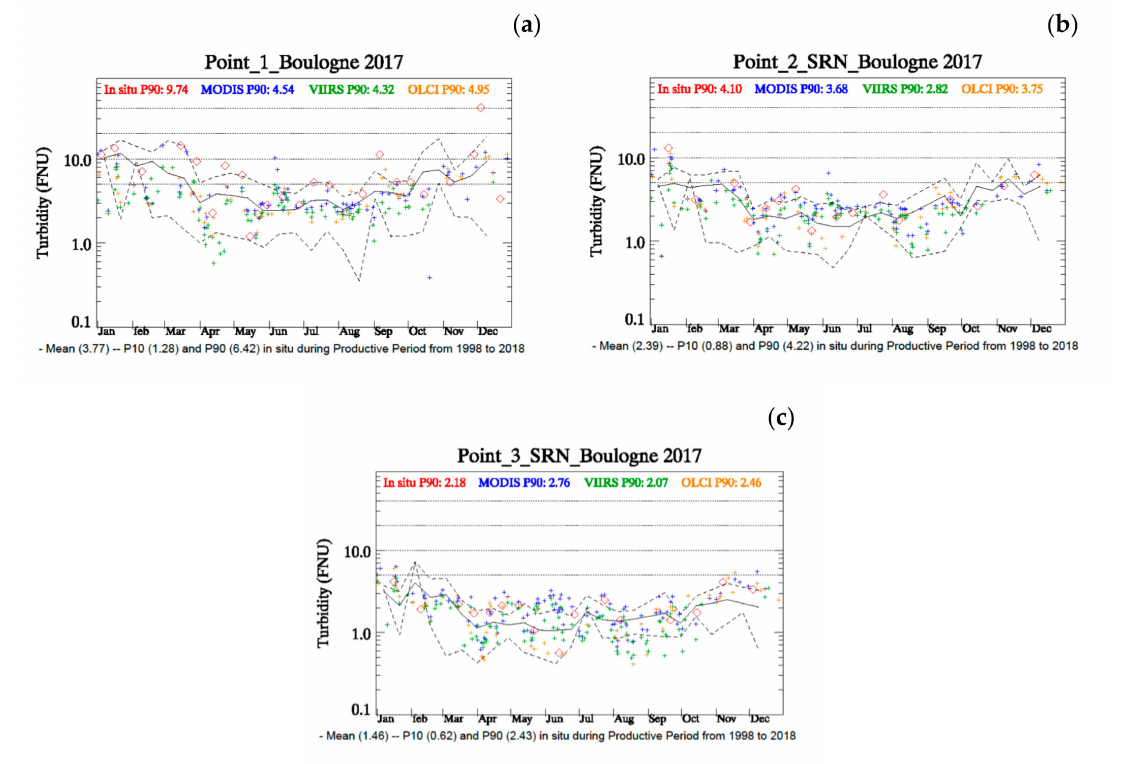
Figure 5. Turbidity along the Boulogne transect ( a : Point 1; b : Point 2; c : Point 3). In situ and satellite percentiles of year 2017 are indicated in the upper part of the graph; the in situ historical mean, P10 and P90, calculated over the productive period, are indicated under the time